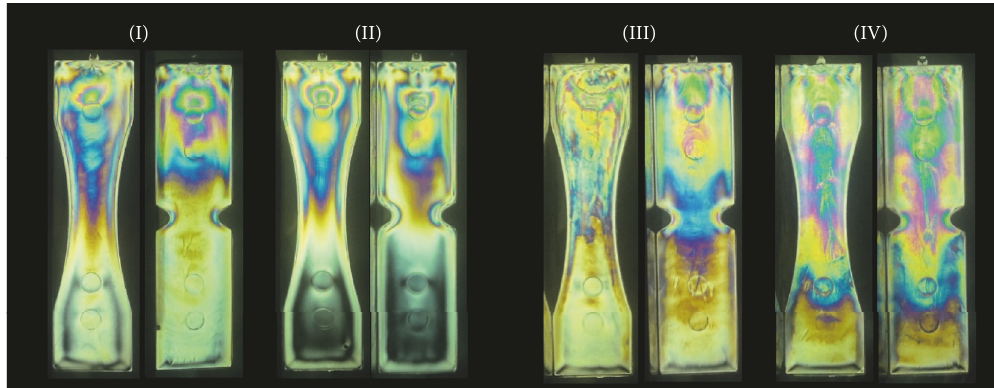
Figure 6: Photoelastic fringes of notched and unnotched specimens for Conditions I, II, III, and IV.